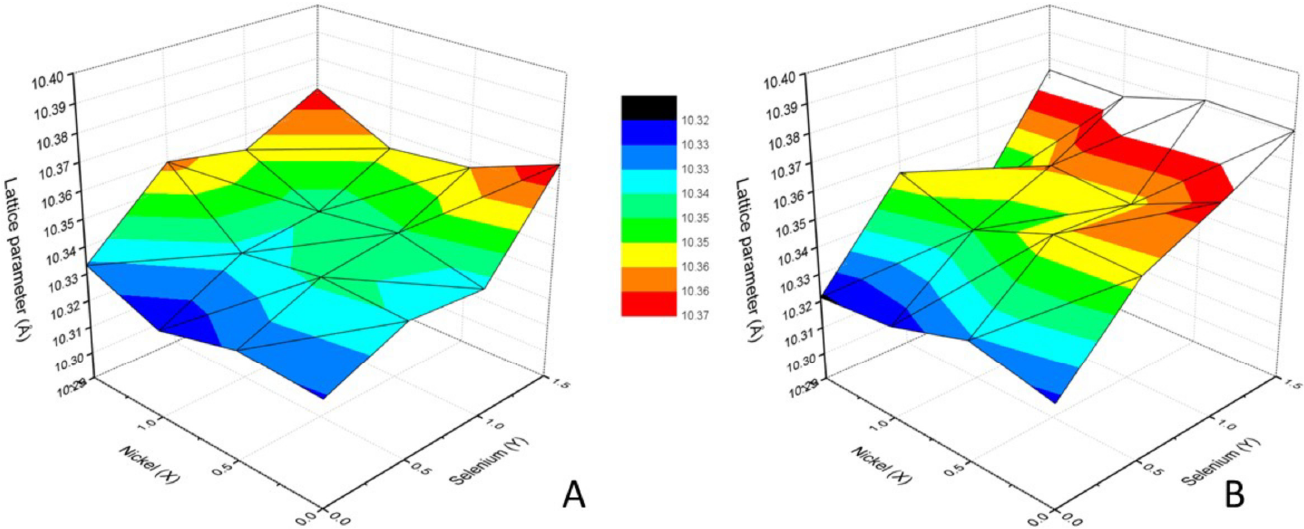
Figure 6. Lattice parameter dependence on Ni content (x) and Se content (y) in as-cast ( A ) and annealed ( B ) Cu 12 − x Ni x Sb 4 S 13 − y Se y samples.